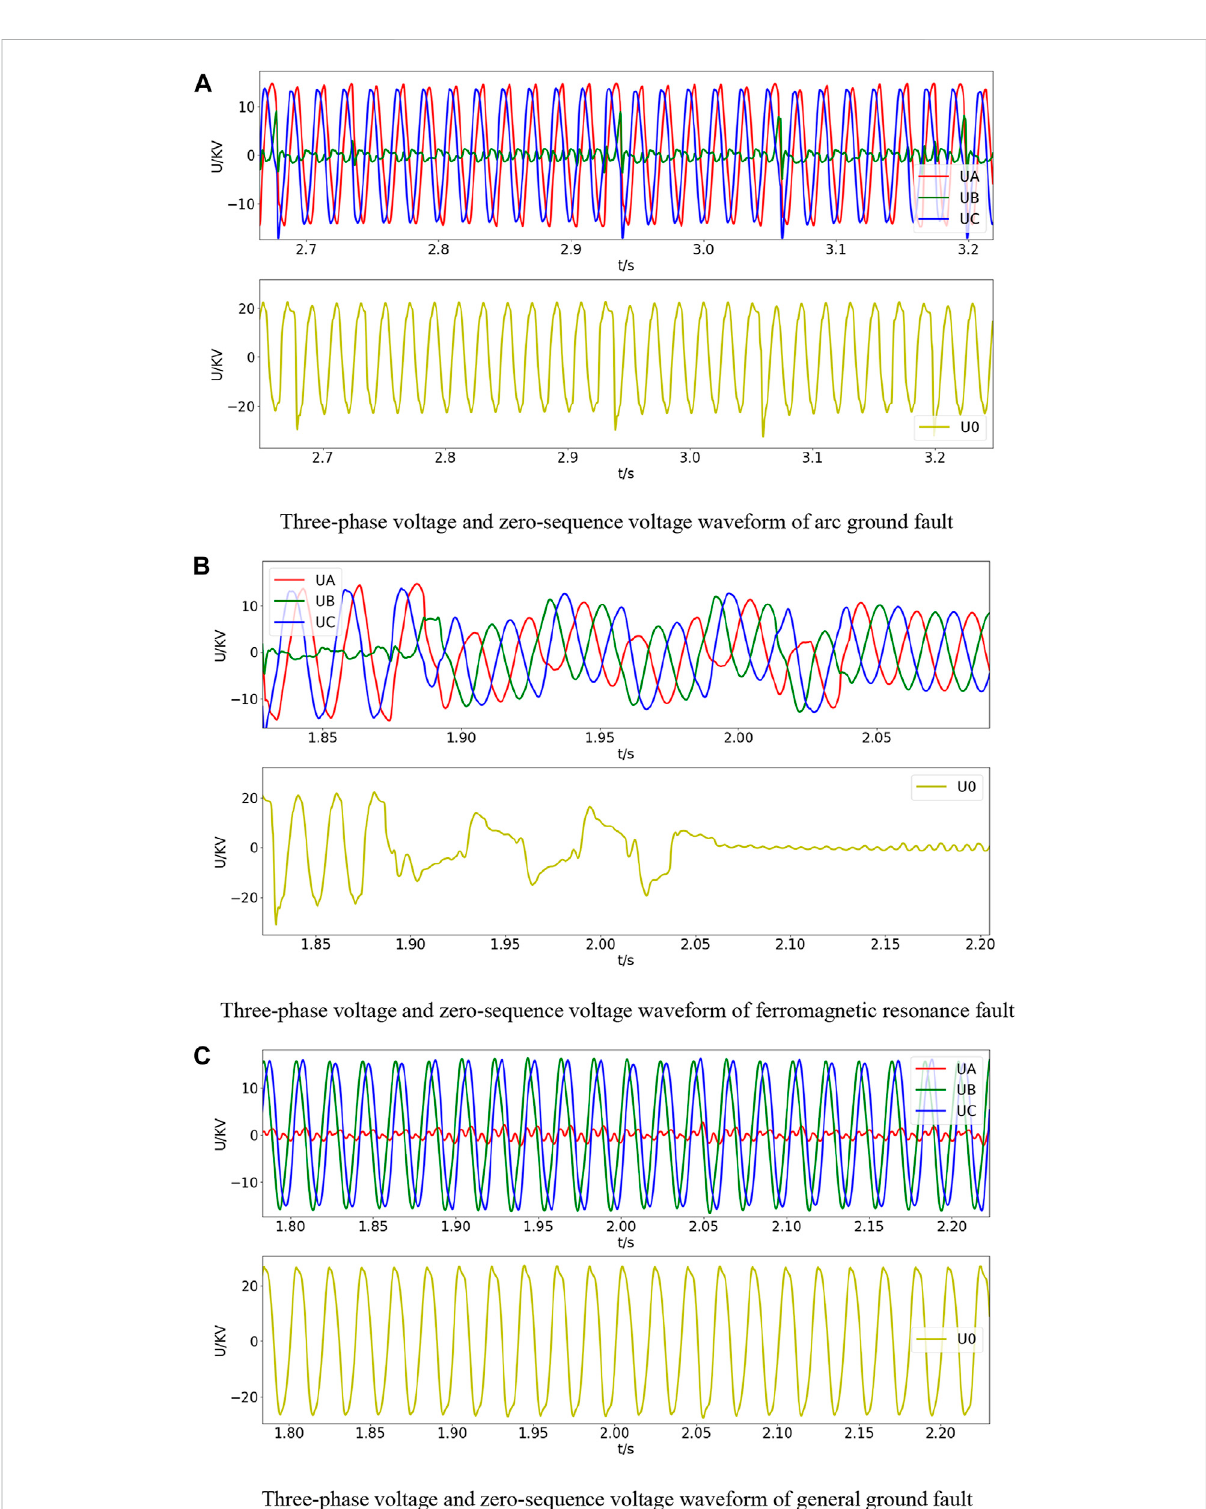
FIGURE 4 Typical failure diagram of the test sample. (A) Three-phase voltage and zero-sequence voltage waveform of arc ground fault. (B) Three-phase voltage and zero-sequence voltage waveform of ferromagnetic resonance fault. (C) Three-phase voltage and zero-sequence voltage waveform of general ground